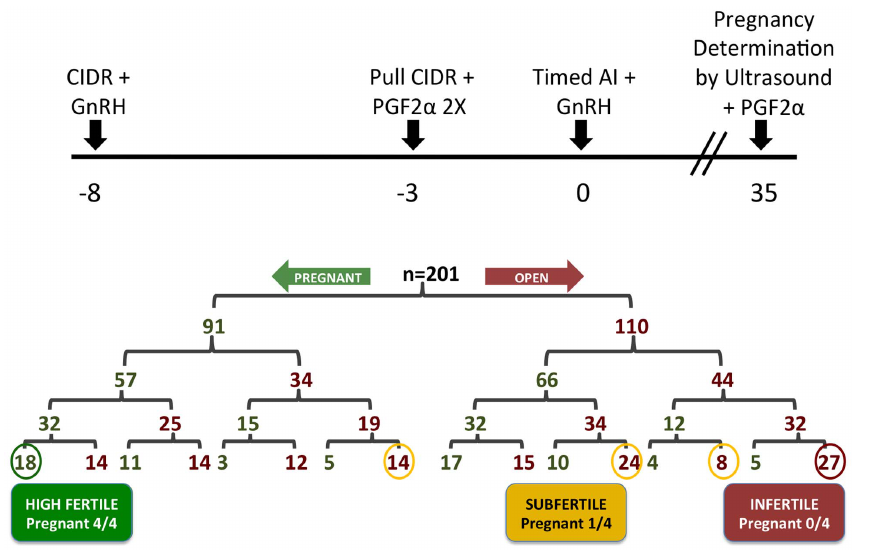
Figure 1. Experimental design and results for selection of beef heifers for uterine capacity for early pregnancy using a serial timed artificial insemination (AI) approach. See text for detailed description of results.